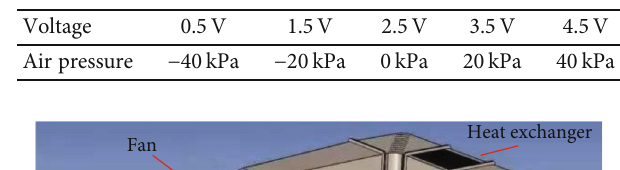
Table 1: Sensor parameters.